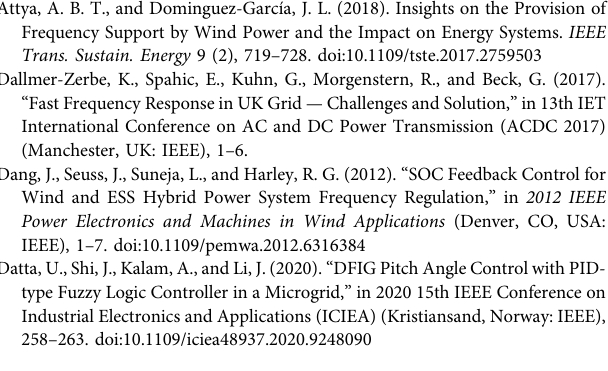
Frontiers in Energy Research |